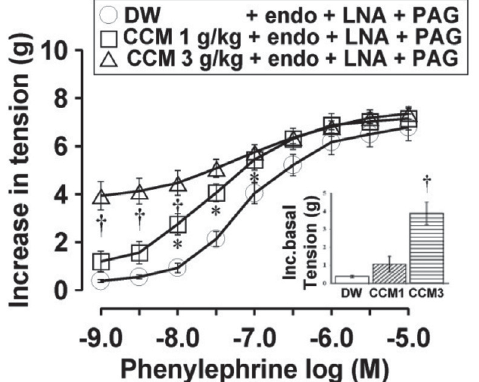
FIGURE 5 - Effects of 6 weeks oral administration of CCM (1 or 3 g/kg) or distilled water (DW, control) on the contractile response to phenylephrine of L-NA pretreated endothelium- intact (endo) thoracic aortic rings in the presence of PAG. Values represent mean ± SEM; n=6. *Significantly higher than the control groups and † significantly higher than the other groups, P< 0.05. Note: Miniature bar graphs in Figure 5 showed the increased basal tension after addition of the